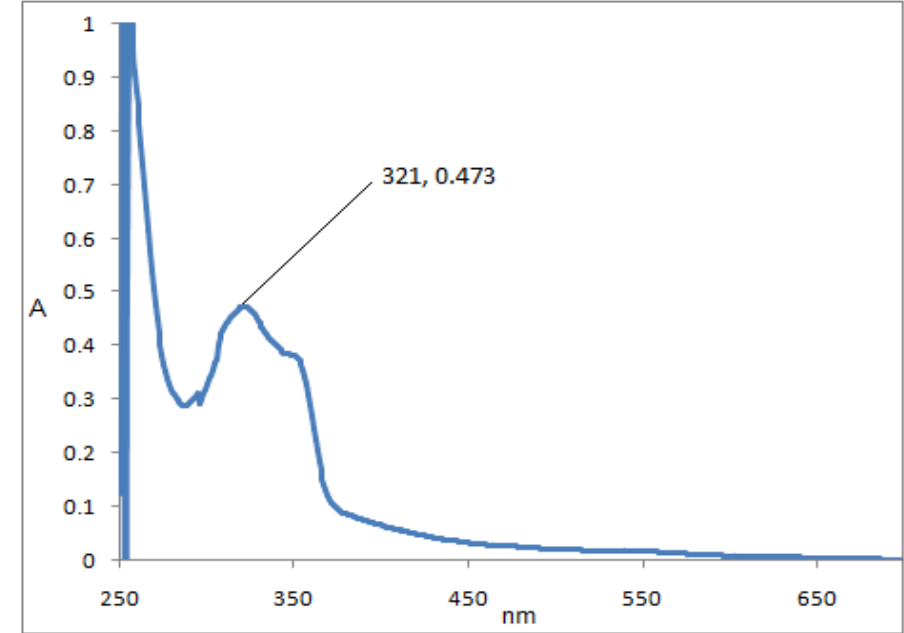
Figure S14: UV/Visible spectrum of Schiff base polyether P m